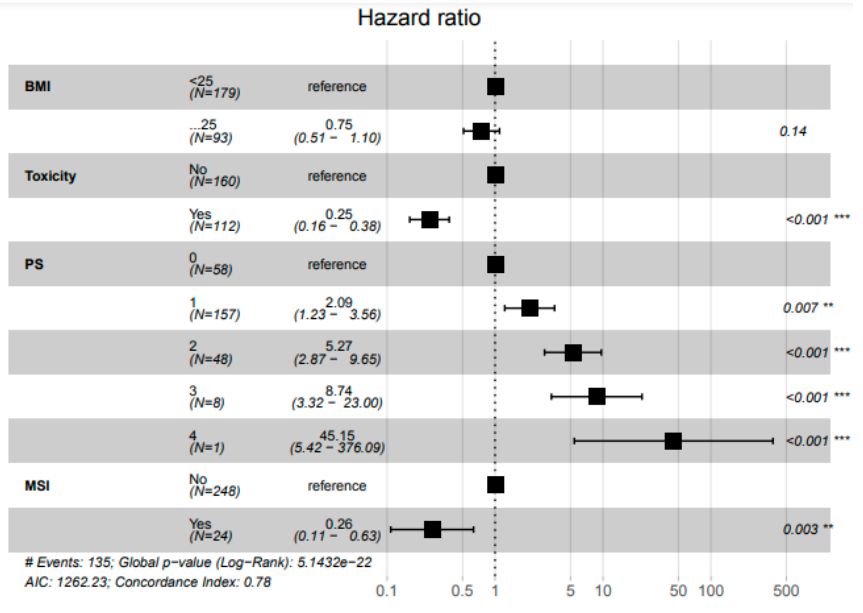
Figure 5. Pooled analysis for overall survival ( n = 272). ** Statistically significant with p < 0.01; *** Statistically significant with p < 0.001